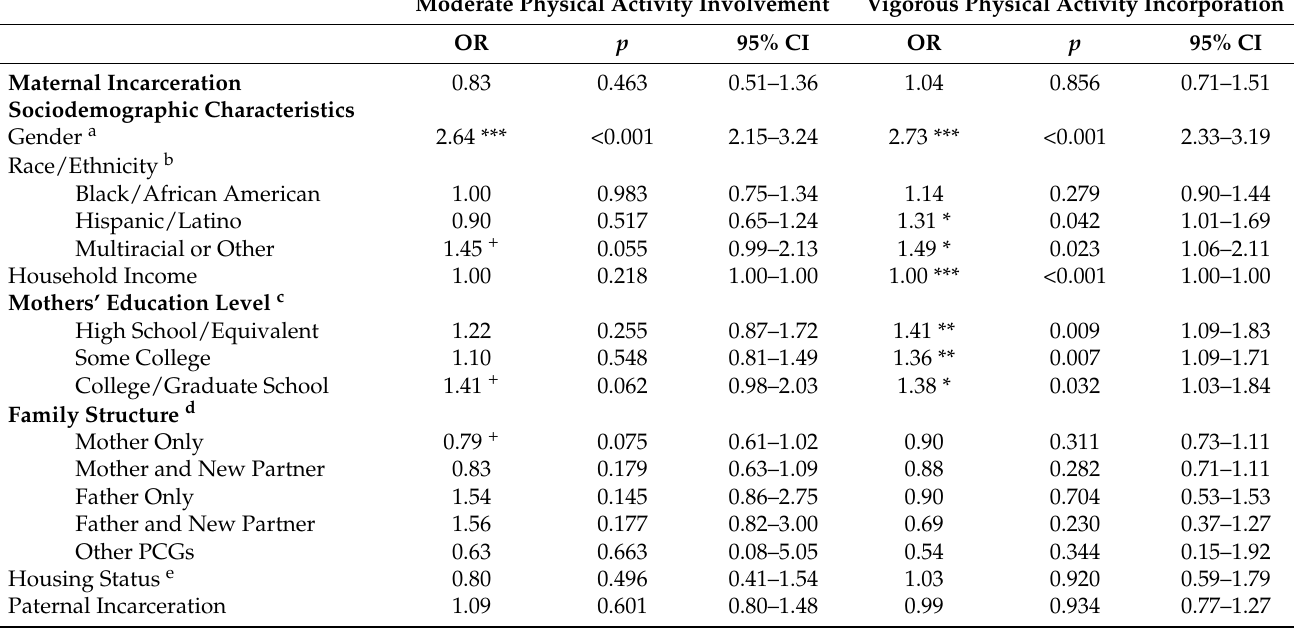
Table 5. Logistic regression models on the association between maternal incarceration and adolescents’ physical activity involvement (FFCW, N =